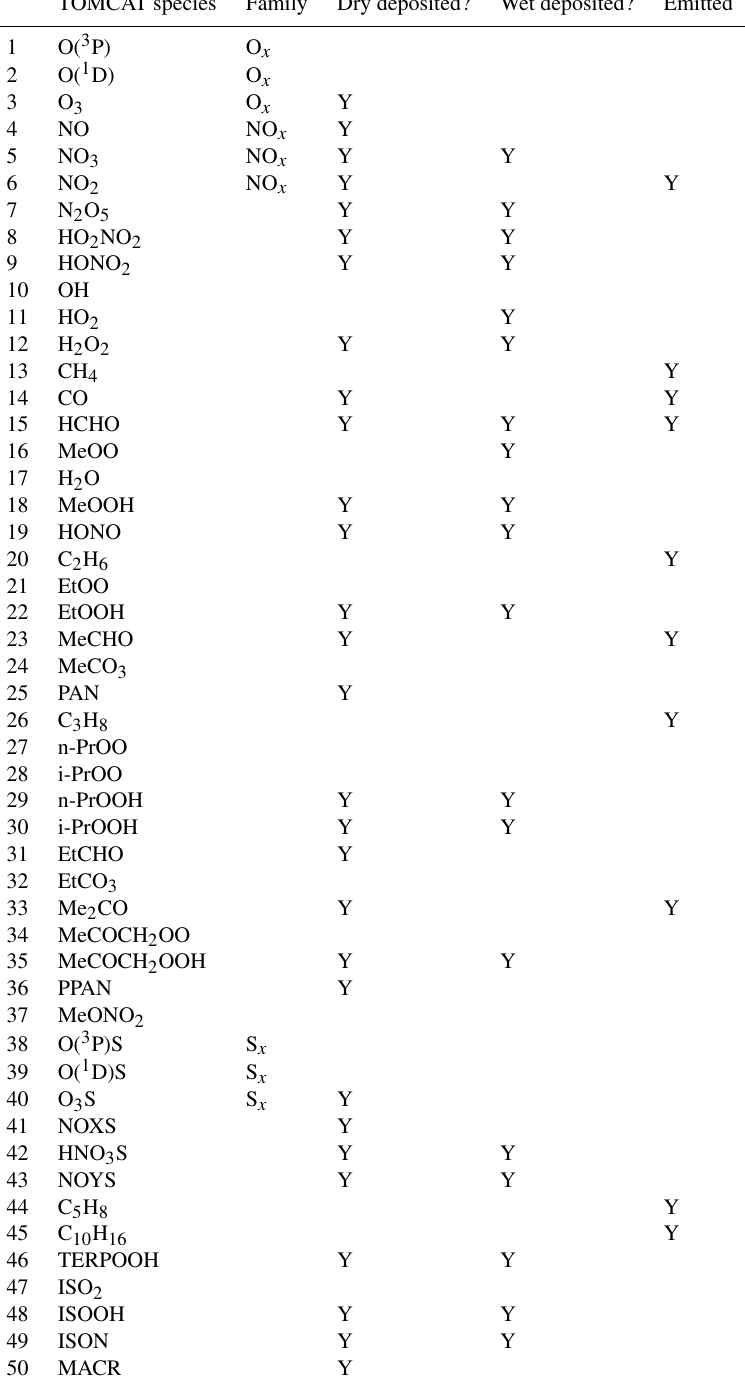
Table 2. Chemical species treated in the tropospheric chemistry scheme of the TOMCAT CTM. If the species are emitted, the “dry deposited” or “wet deposited” categories are marked with a Y in the relevant column. The family column indicates which short-lived species are grouped together for advection and chemistry. TOMCAT abbreviations: Me indicates CH 3 , Et indicates C 2 H 5 , Pr indicates C 3 H 7 , MACR indicates lumped species (methacrolein, methyl vinyl ketone and other C4 carbonyls), HACET indicates hydroxyacetone, MGLY indicates methyl- glyoxal, NALD indicates nitrooxy acetaldehyde, TERP indicates generic terpene compound, AROM indicates generic aromatic compound, MEK indicates methyl ethyl ketone, Prpe indicates C 3 H 7 O, ONIT indicates organic nitrate, and S indicates stratospheric tracer (TOMCAT species